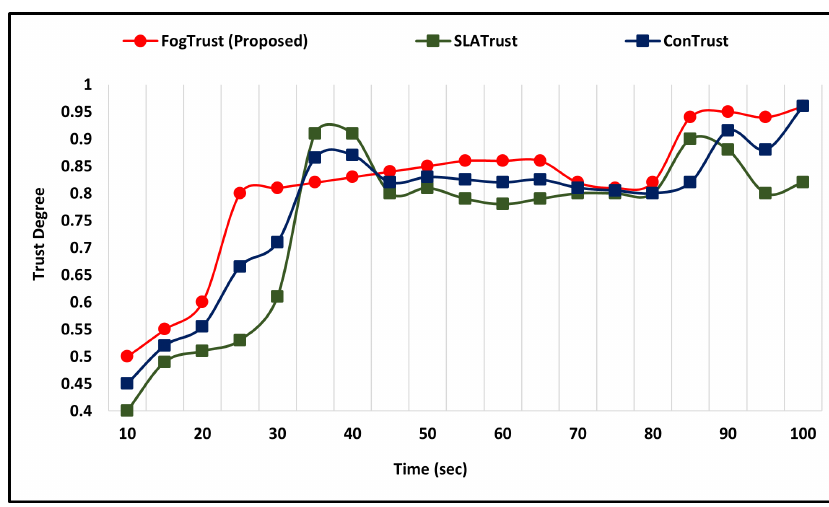
Figure 6. Comparative Analysis Against Bad-Mouthing